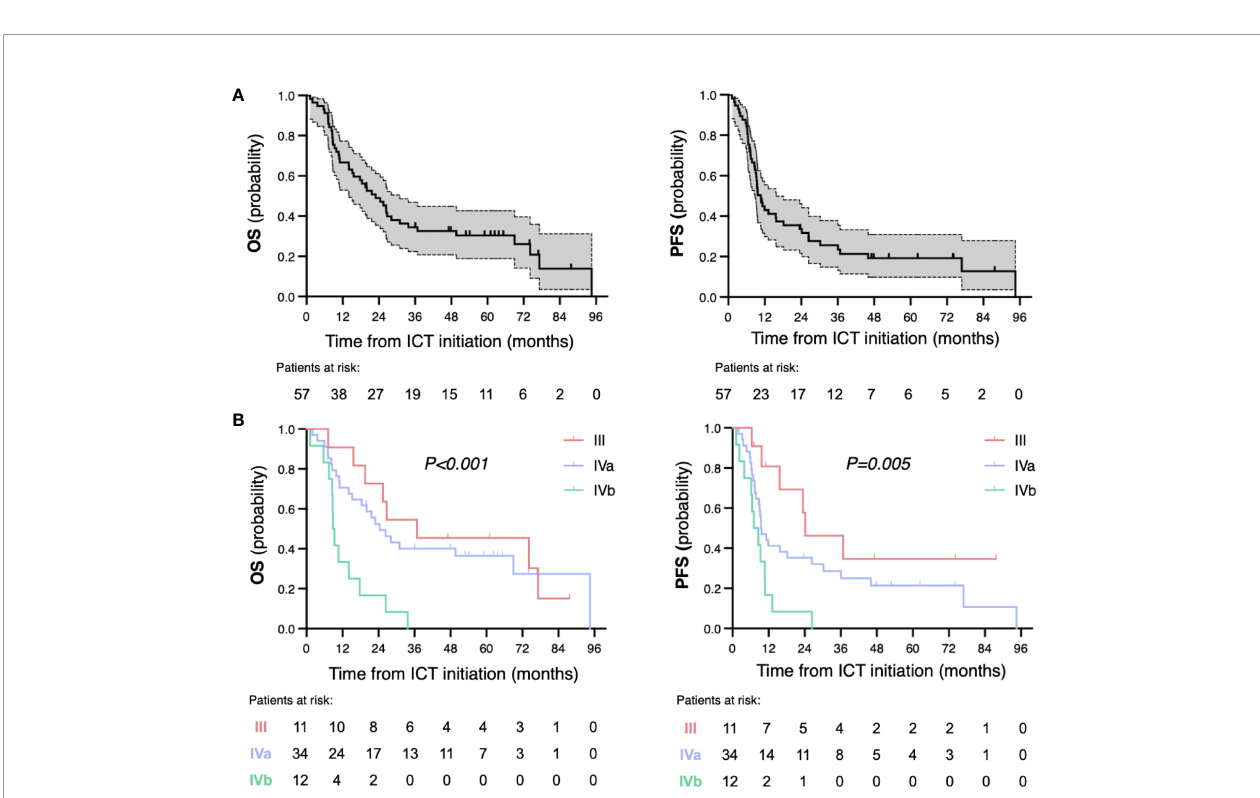
FIGURE 3 | Kaplan – Meier survival curves for overall survival (OS) and progression-free survival (PFS) of the whole cohort (A) and by tumor stages (B) . p represents log-rank p -value for subgroup comparison. ICT, induction